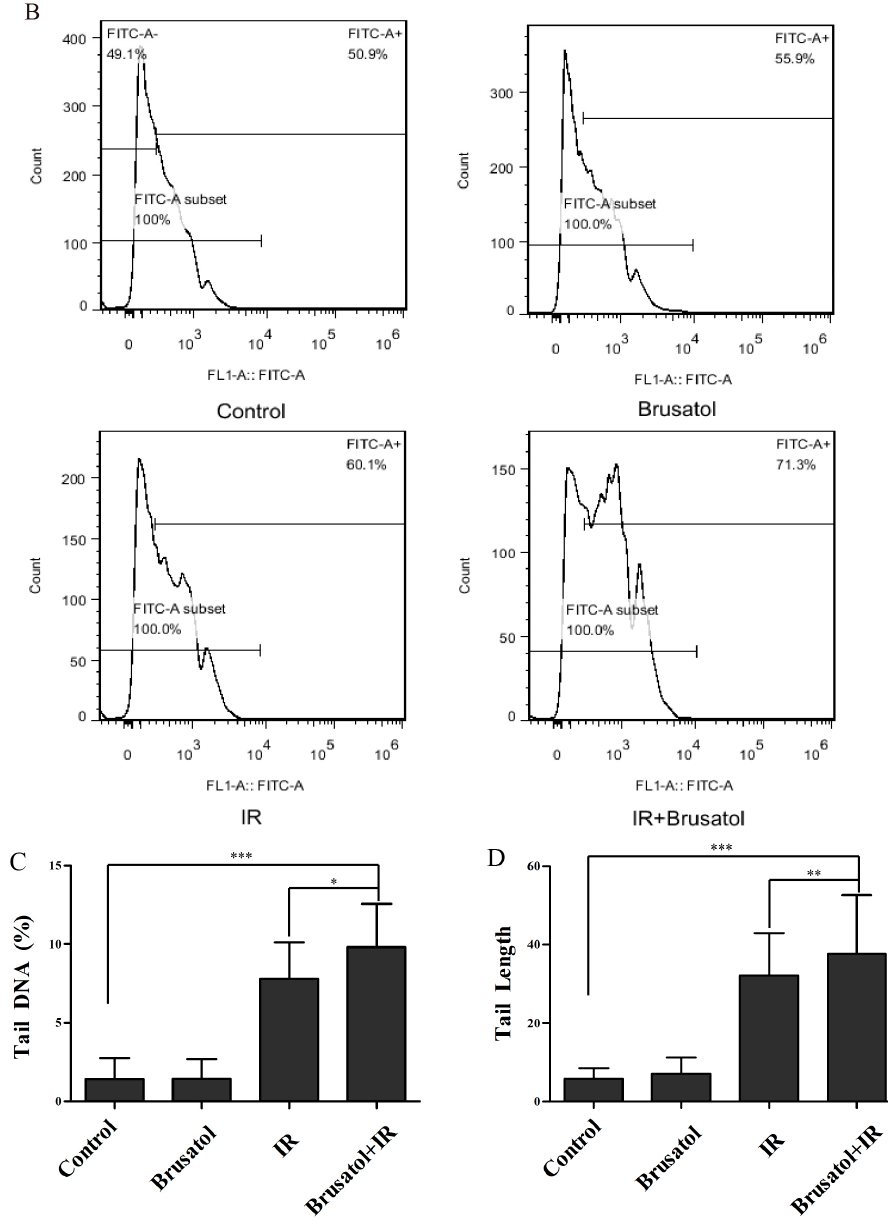
Figure 3. Cont. Figure 3.